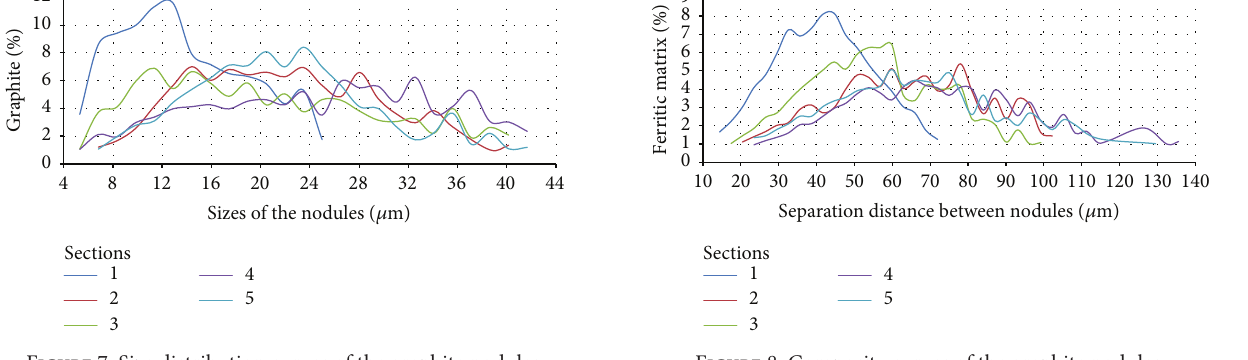
Figure 7: Size distribution curves of the graphite nodules. Figure 8: Compacity curves of the graphite